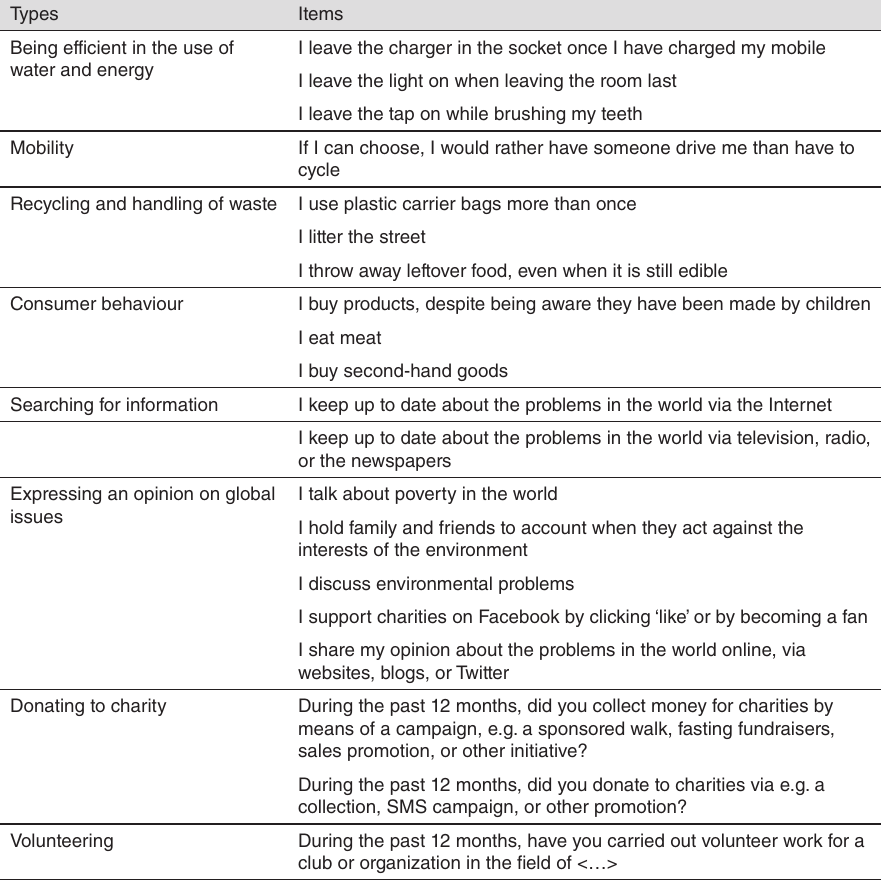
Table 1: Empirical properties of global citizenship behaviour